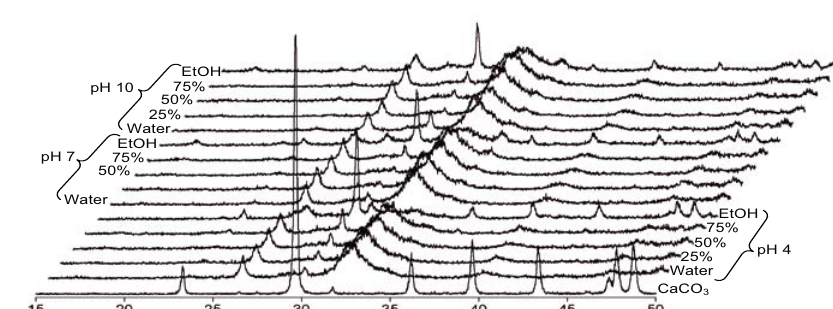
Figure 4. XRD patterns of the products obtained at 80°C.